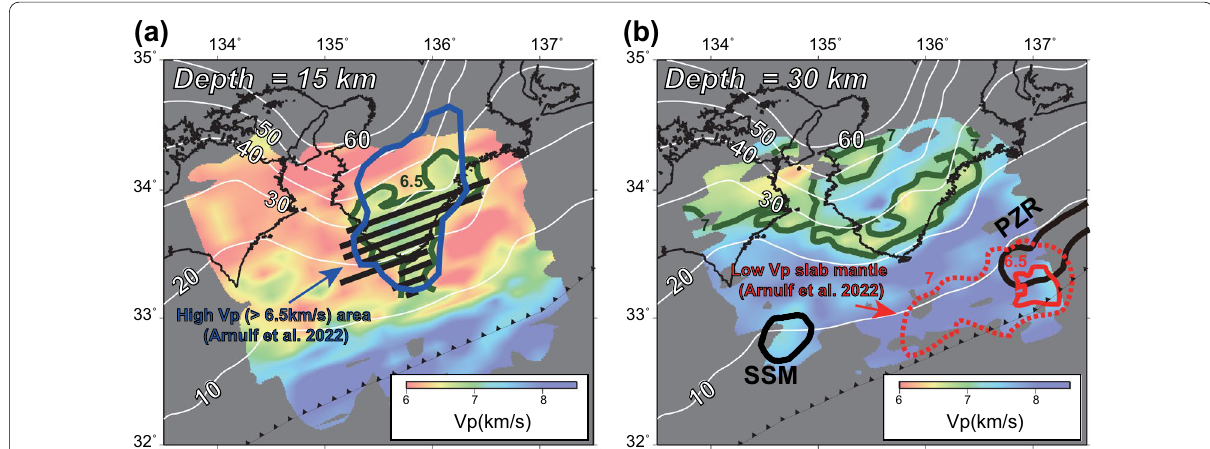
Fig. 10 P-wave structure along the depth slice. a At 15 km depth. The green line is the iso-value contour of Vp show the spatial extent of Vp > 6.5 km/s along the Y direction ( et al. (2022). b At 30 km depth. The green line is the iso-value contour of Vp contours of 6.5 km/s and 7.0 km/s 15 km deeper than slab Moho discontinuity estimated by Arnulf et al. (2022),